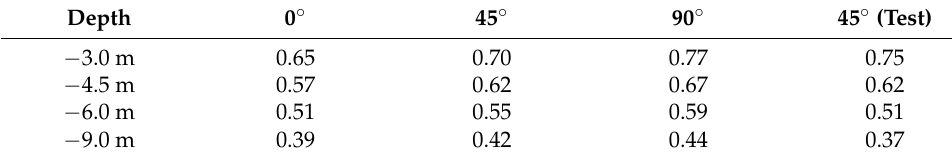
Figure 12. Numerical simulation and test results of peak value of EPWPR. Table 6. Comparison of the peak values of EPWPR at different